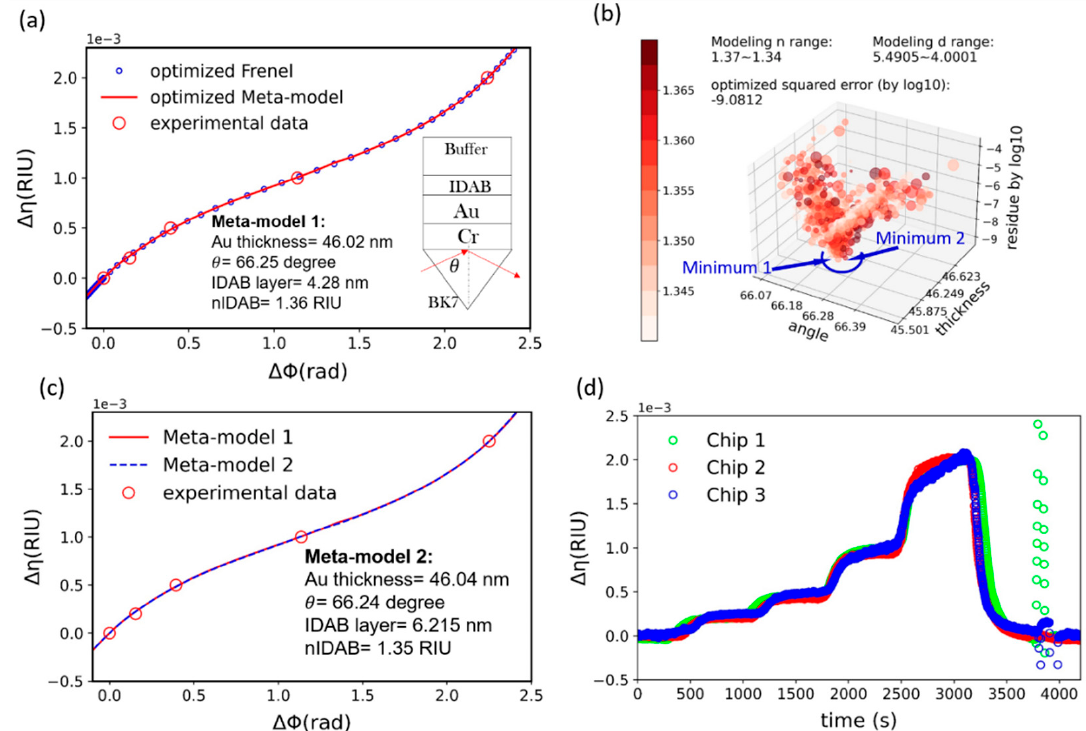
Figure 5. ( a ) Meta-model mapping functions corresponding to chip-1 in Figure 4a. In the figure, the red curve represents the optimized meta-model, the red circles represent the experimentally measured data and the blue circles represent the corresponding Fresnel model. ( b ) Proposed visualization chart for the meta-model 1. ( c ) Comparison of meta-model 1 and meta-model 2. ( d ) The sensorgram of the chip-1 to chip-3 after the conversion by the algorithm.